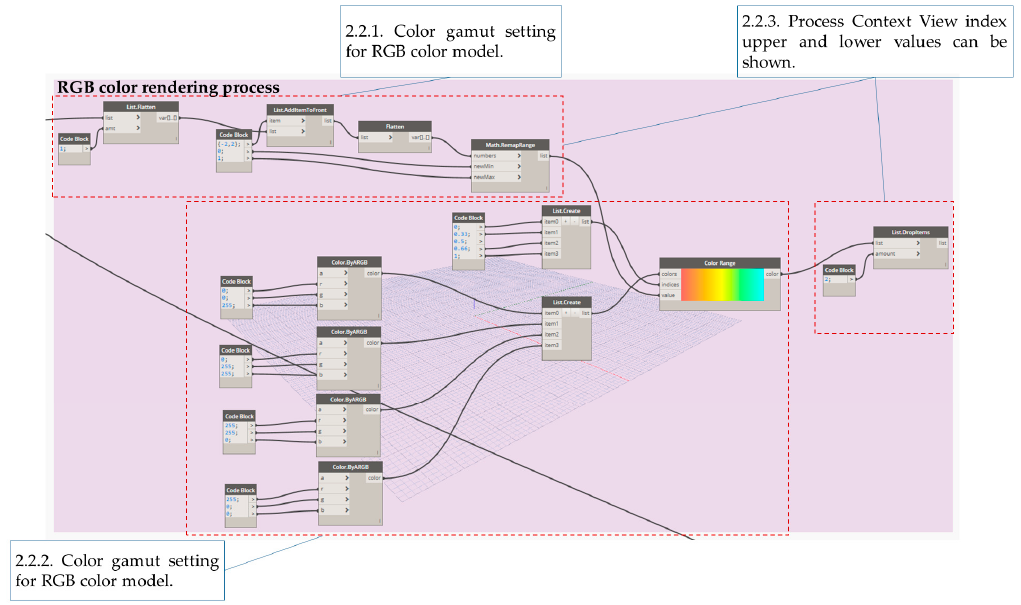
Figure 9. Grid data and RGB conversion.